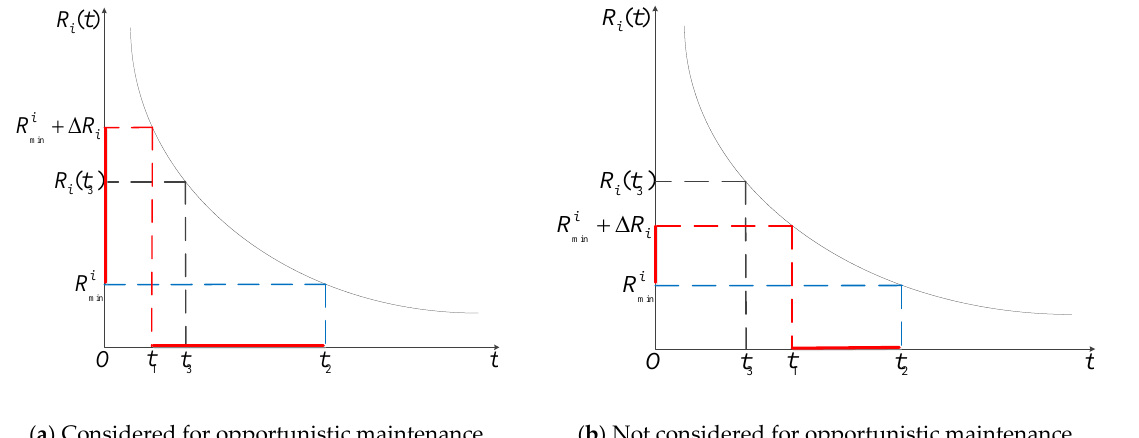
Figure 4. Schematic diagram of component reliability.